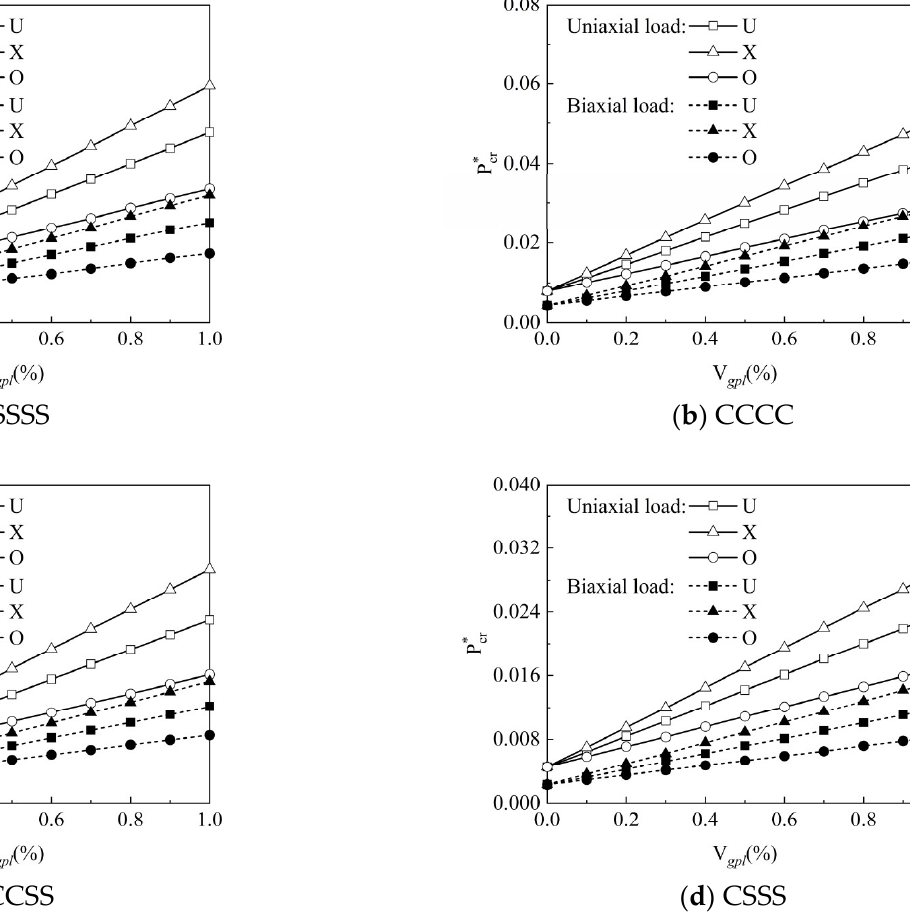
Figure 11. Variation of dimensionless critical buckling load along graphene volume fractions for the ( a ) SSSS, ( b ) CCCC, ( c ) CCSS, and ( d ) CSSS FG-GRP plates subjected to uniaxial and biaxial in-plane forces.